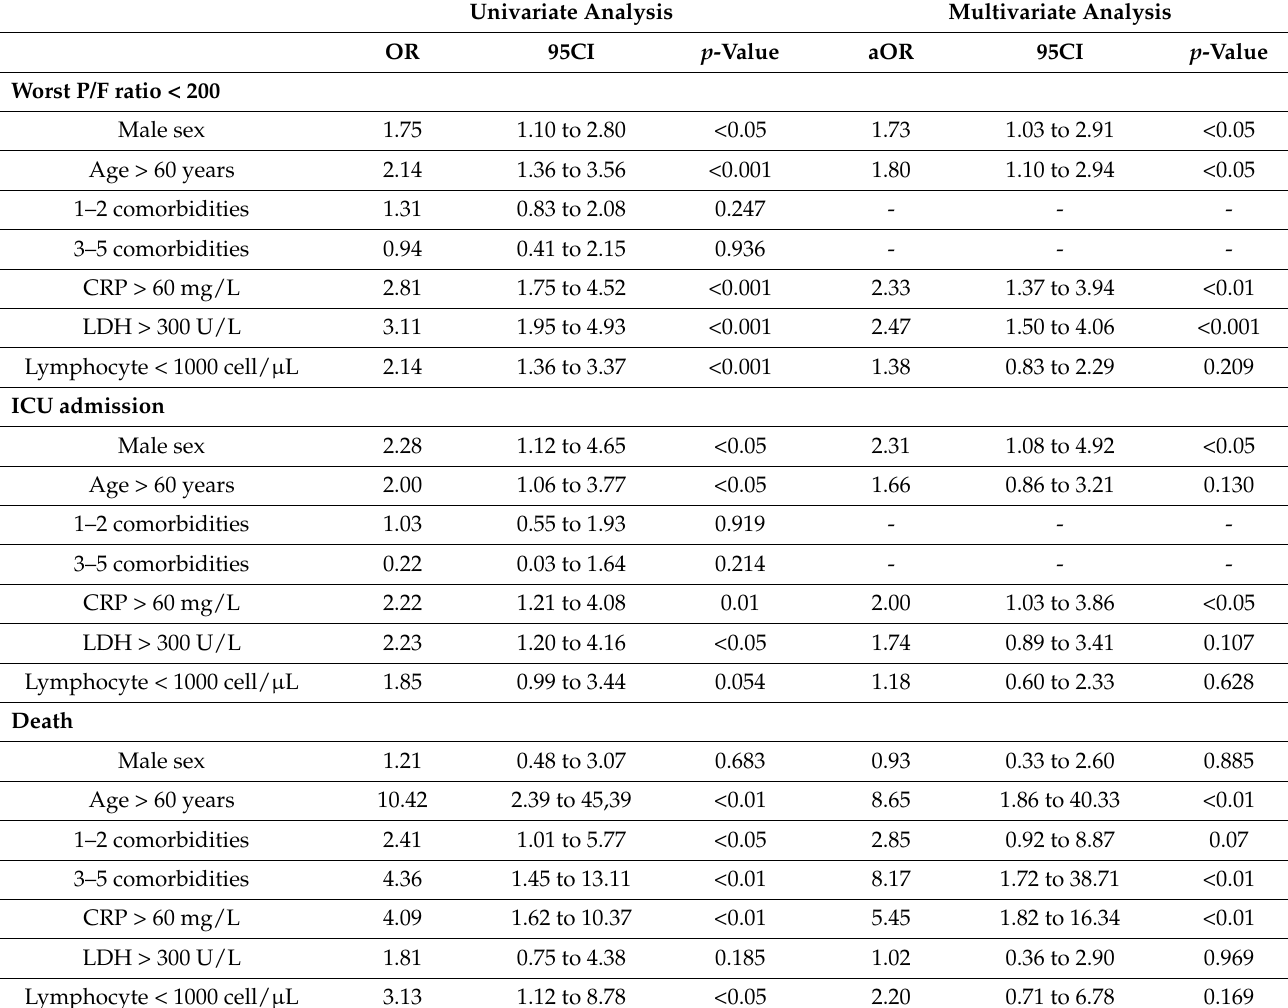
Table 4. Univariate and multivariate logistic regression analysis for worst P/F ratio < 200. Univariate